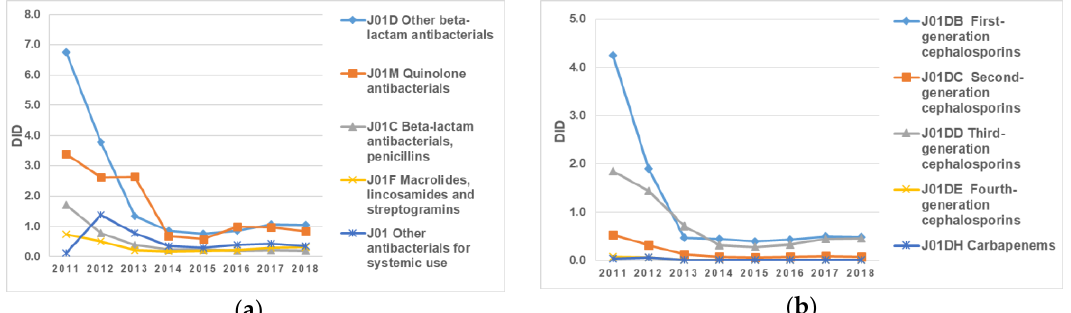
Figure 2. ( a ) Dynamics of changes in the most consumed pharmacological groups of antibiotics purchased within the context of guaranteed free medical care in the period 2011–2018; ( b ) dynamics of changes in the proportions of the most consumed pharmacological groups of antibiotics purchased in the context of guaranteed free medical care for the period 2011–2018 by pharmacological group.